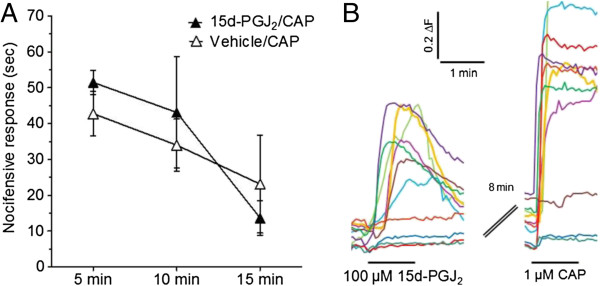
15d-PGJ2 does not affect cellular or behavioral responses to CAP. (A) 100 μM 15d-PGJ2 did not affect the response magnitude induced by 1 μM CAP (B). In agreement with calcium imaging of DRG data, pre-treatment with 15 mM 15d-PGJ2 (10 μL ipl.) did not inhibit behavioral responses to an 1.6 μg CAP (10 μL ipl.).